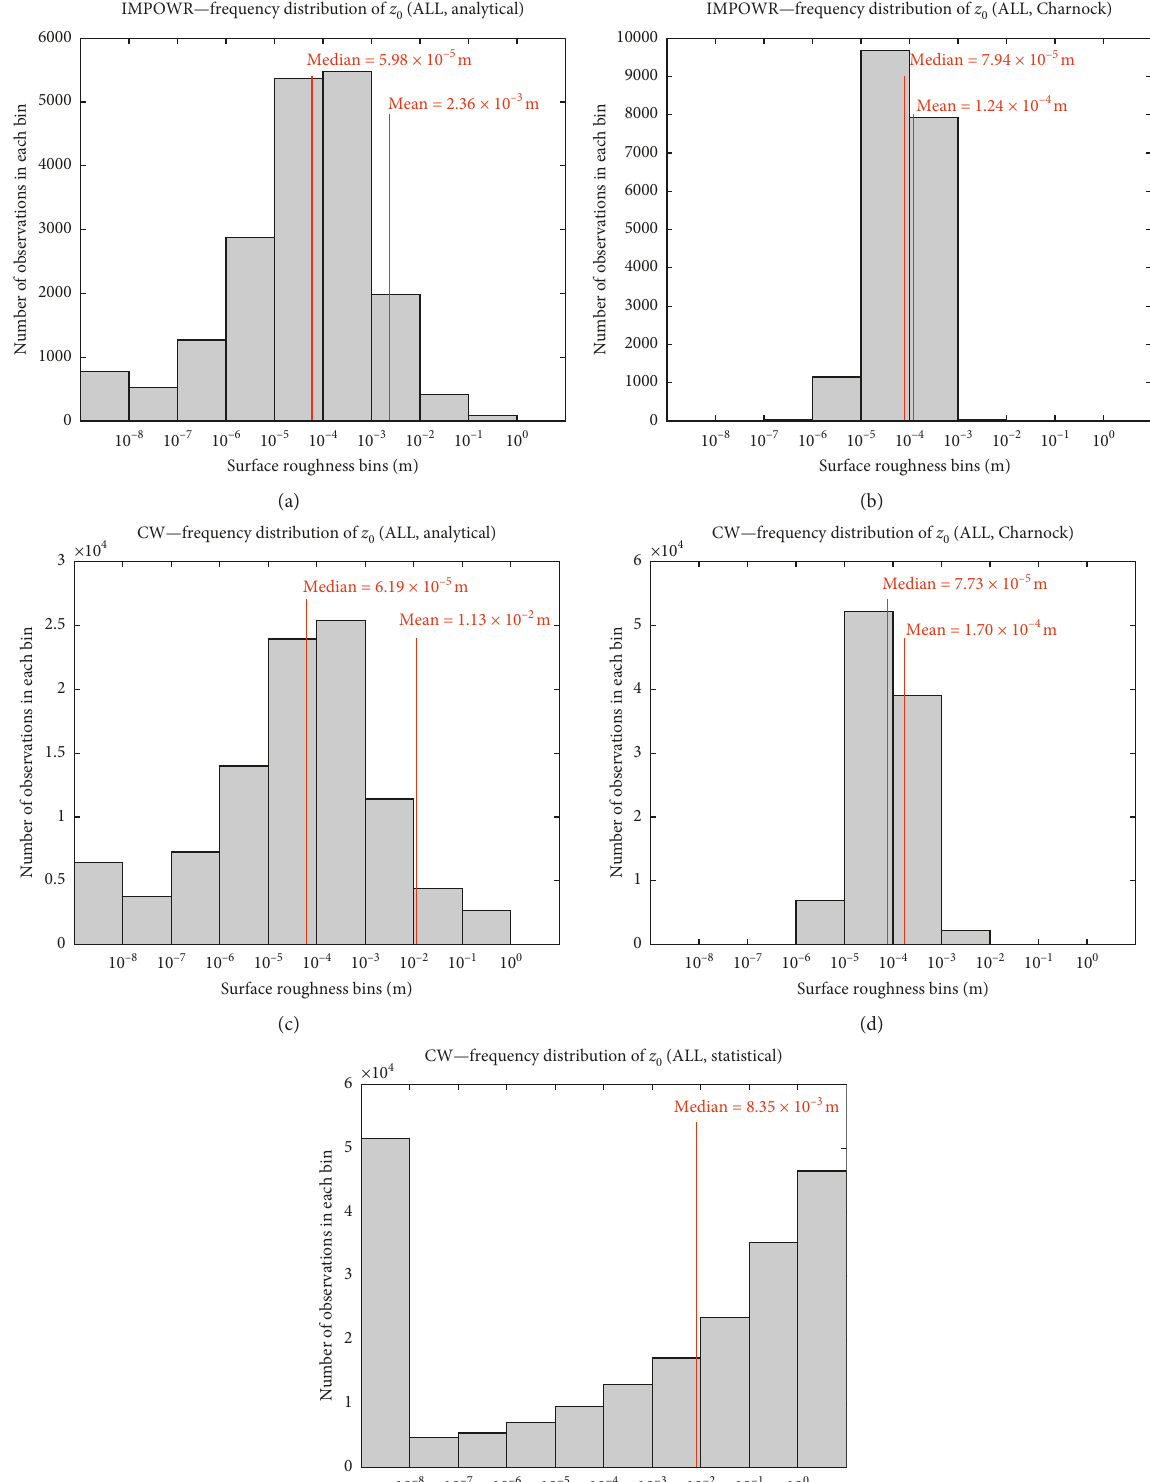
Figure 2: Frequency distribution of surface roughness length from the 2013–2014 IMPOWR campaign with two sonic anemometers located at 12m AMSL and (a) the analytical method and (b) the Charnock method and the 2003–2007 CW Historical campaign with (c) the analytical method using a sonic anemometer located at 20m AMSL, (d) the Charnock method using a sonic anemometer located at 20m AMSL, and (e) the statistical method using pairs of sonic and cup anemometers at 20, 41, and 60 m AMSL. The mean and median z 0 are displayed on each figure. The x -axis is logarithmic and the y -axis has different maxima in each figure. Note that the statistical method is not intended to give realistic values of surface roughness length; thus, its distribution is shown here in (e) just for